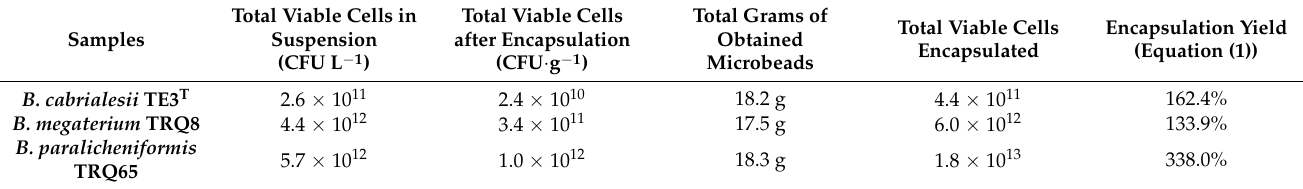
Table 1. Survival of Bacillus strains encapsulated in dry microbeads ( n = 3). Data represent the mean. Total Viable Cells in Samples